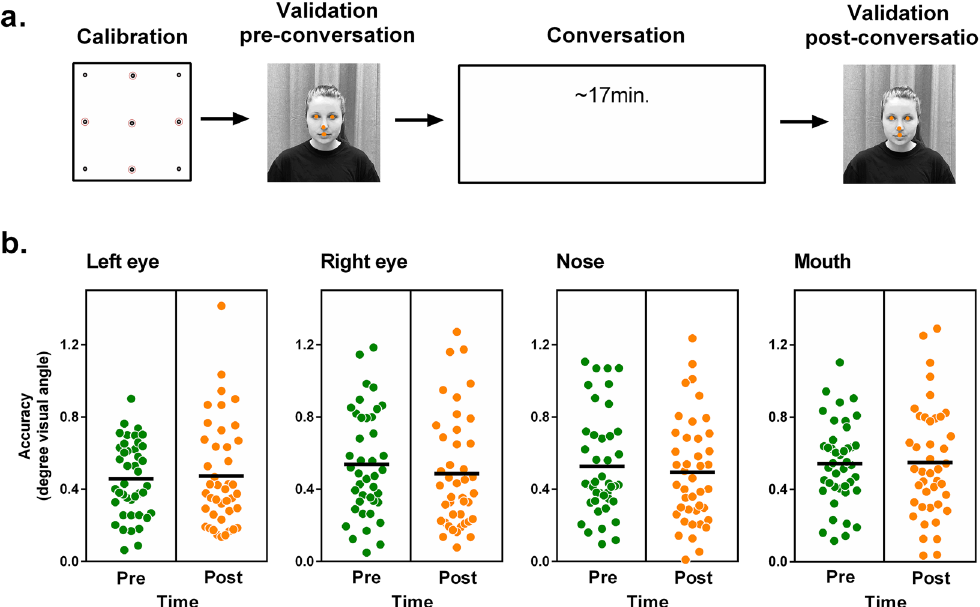
Figure 5. Accuracy for the validation sequence pre- and post-conversation. ( a ) The calibration was followed by a validation sequence on the face of the conversation partner. After a conversation of about 17 min, another validation sequence was added. ( b ) Accuracy for the different facial target locations in degrees visual angle. Black lines represent mean values. Lower values represent better